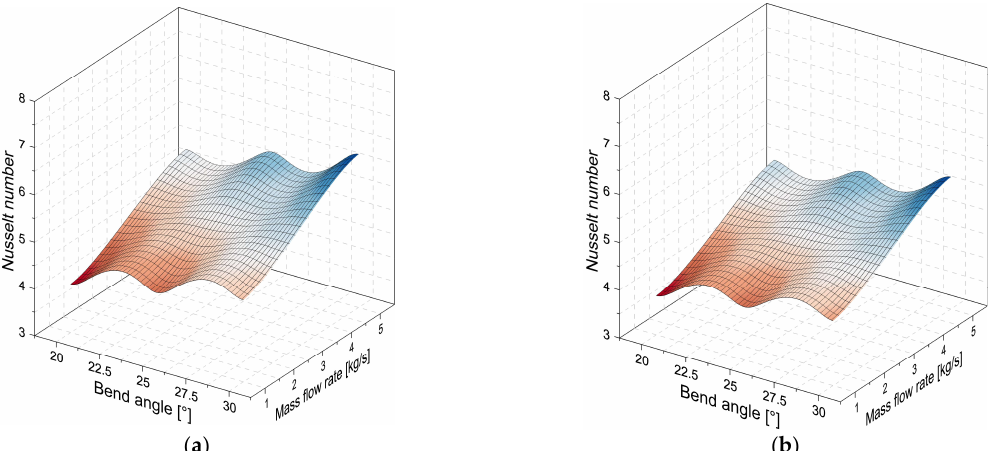
Figure 15. Effect of bend angle on Nusselt number: ( a ) conventional zig-zag channel; ( b ) modified zig-zag channel.